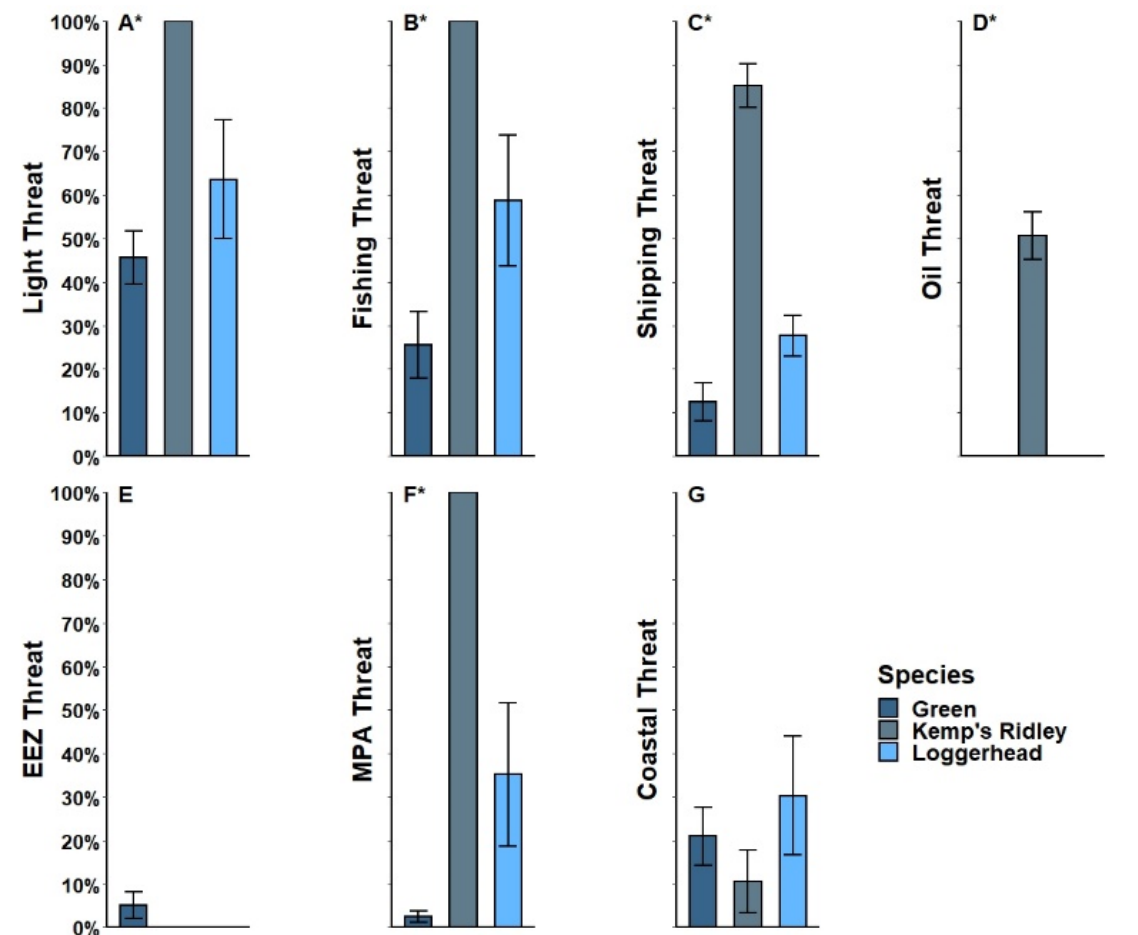
Figure 7. Average percentage of days a high threat was encountered by species. Error bars represent standard error. High threats were classified by threat scores above the median value for the given threat. PERMANOVA results found that threat scores significantly differed for 5 out of 7 threat variables ( Light Pollution ( A )—F 2,36 = 7.9462, p = 0.002, Fishing ( B )—F 2,36 = 11.03, p = 0.001, Shipping ( C )—F 2,36 = 34.523, p = 0.001, Oil ( D )—F 2,36 = 259.6, p = 0.001, and Marine Protected Area ( MPA ) ( F )— F 2,36 = 52.837, p = 0.001), for all of which Kemp’s ridleys scored the highest. Nonsignificant variables were Coastal ( G ) and Exclusive Economic Zone ( EEZ ) ( E ) threats (F 2,36 = 0.6355, p = 0.504 and F 2,36 = 0.7947, p = 0.479, respectively). Asterisks (*) next to each embedded figure letter denote a significant